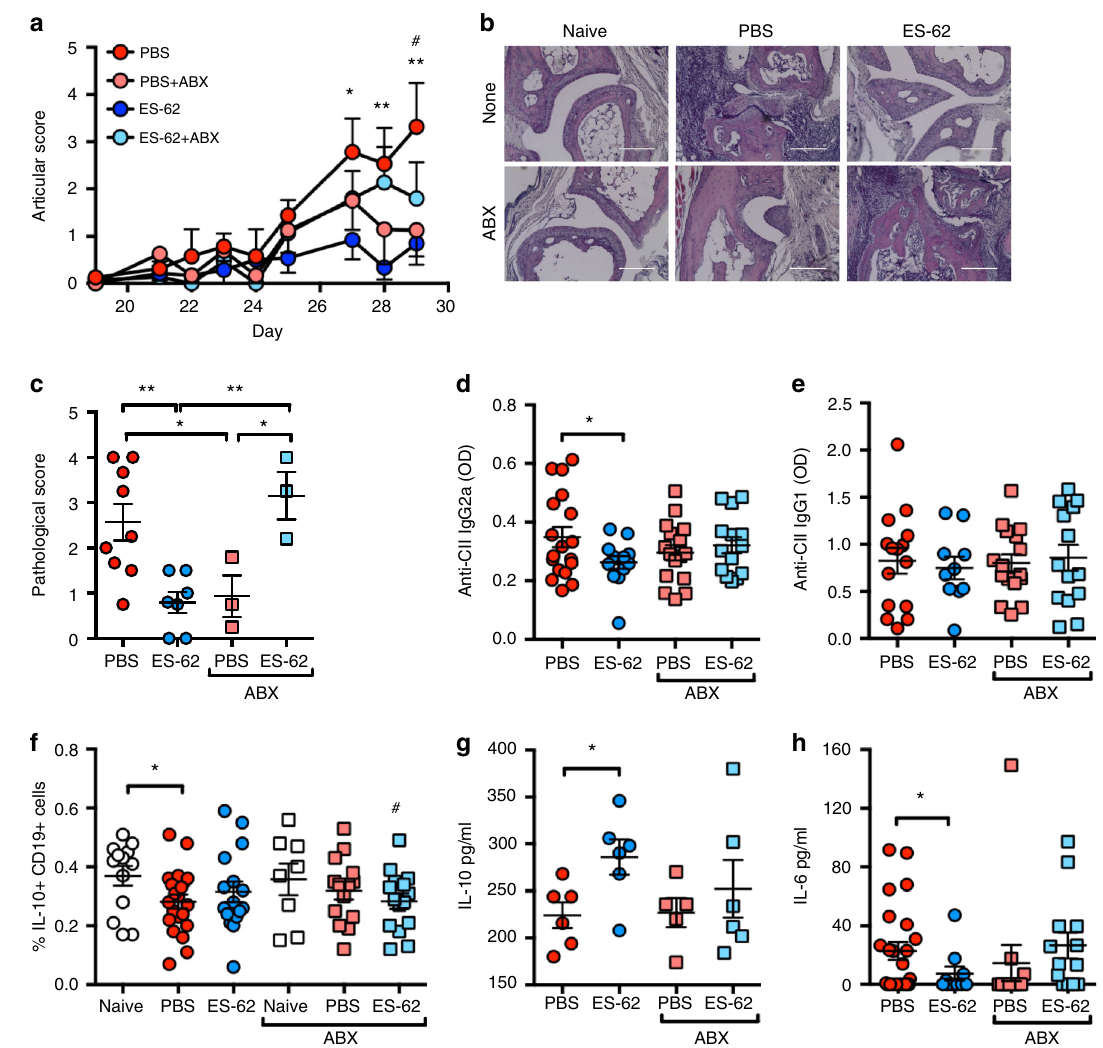
Fig. 2 Antibiotic treatment results in an intermediate disease phenotype. a Data are presented as articular scores (mean ± SEM) and are pooled from three independent experiments (PBS; n = 23, ES-62; n = 19, PBS-ABX; n = 22 and ES-62-ABX; n = 22). b H&E staining (scale bars represent 200 µ m) of hind paws, from representative mice from each treatment group (clinical articular scores of individual paws were: PBS ≥ 3 ( n = 9), ES-62 = 0 ( n = 7), PBS- ABX = 0 ( n = 3) and ES-62-ABX ≥ 3 ( n = 3)) selected to compare joint pathology occurring in the similarly scored ES-62-CIA and PBS-ABX (score 0) and ES-62-ABX and PBS-CIA (articular score ≥ 3) mice. c Blind scoring of pathology exhibited in joint sections imaged in ( b ). d , e Levels of collagen II